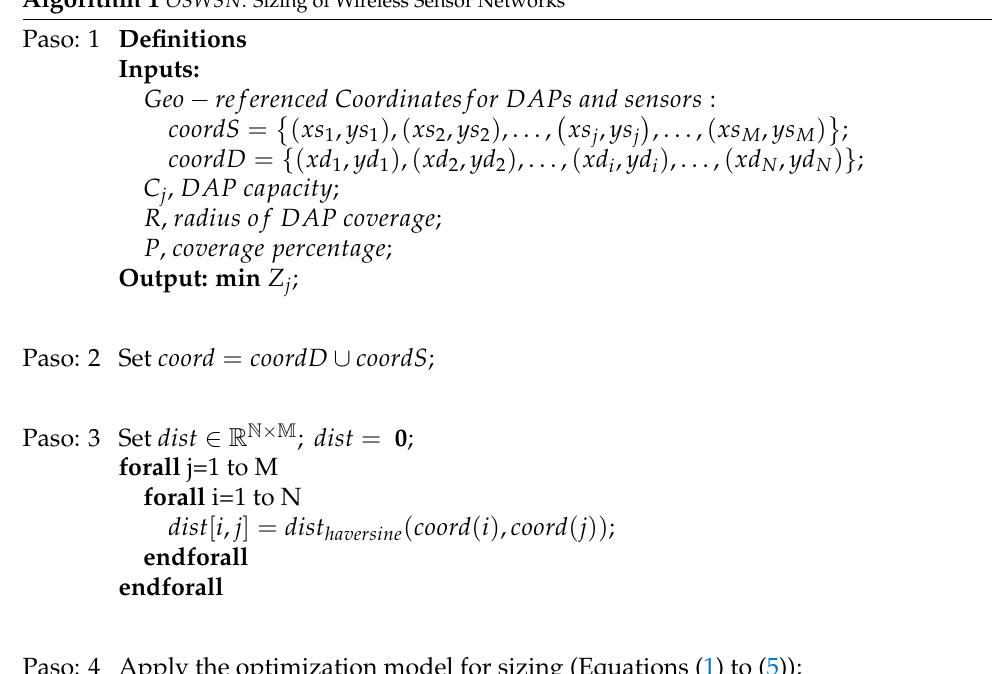
Algorithm 1 OSWSN : Sizing of Wireless Sensor